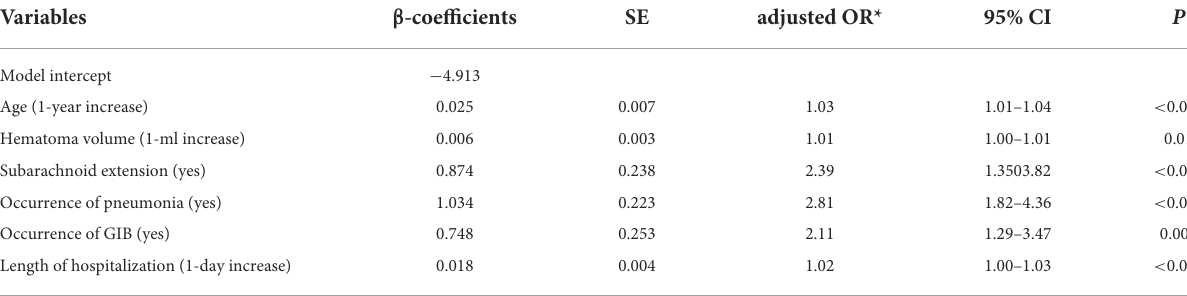
TABLE 2 Multivariable predictors of in-hospital DVT after ICH in the derivation cohort ( n =